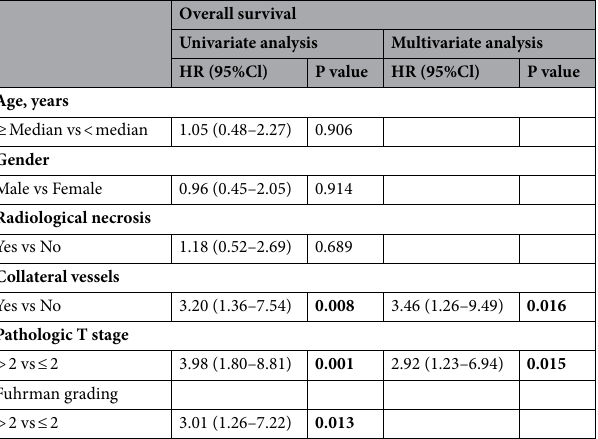
Table 3. Univariate and multivariate analyses of factors in predicting overall survival. HR hazard ratio; CI confidence interval.